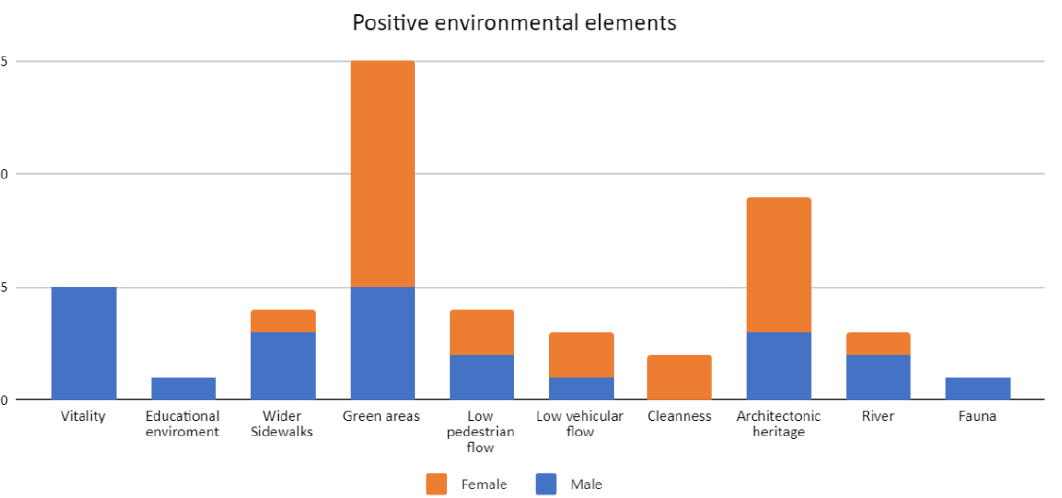
Figure 5. Positive environmental elements mentioned during walking interviews in Barrios Bajos, Valdivia. Source: Authors.